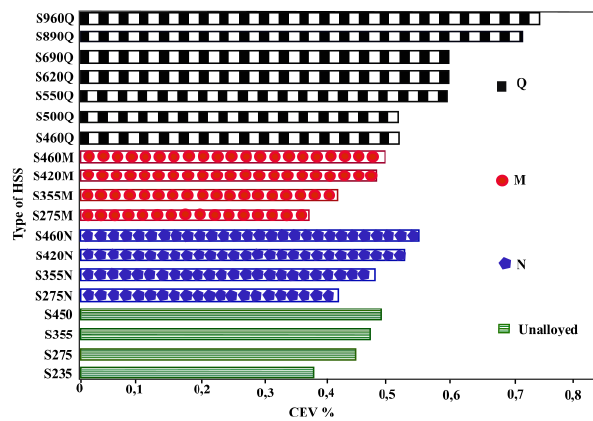
Figure 3: Comparison of the carbon equivalent value (C EV ) of the constitution of steel internal composition, EN 10025-3, -4, and -6 with unalloyed steel structures, EN 10025-2. Reprinted with permission from Schulze // Heidelberg-Dordrecht. (2009). ©2009 Springer